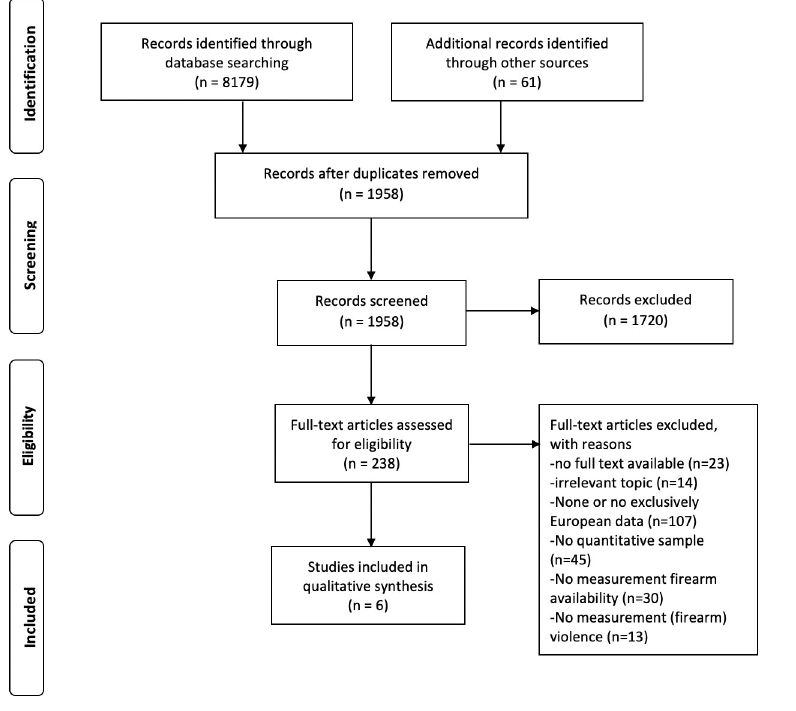
Fig 1. Flow chart of systematic